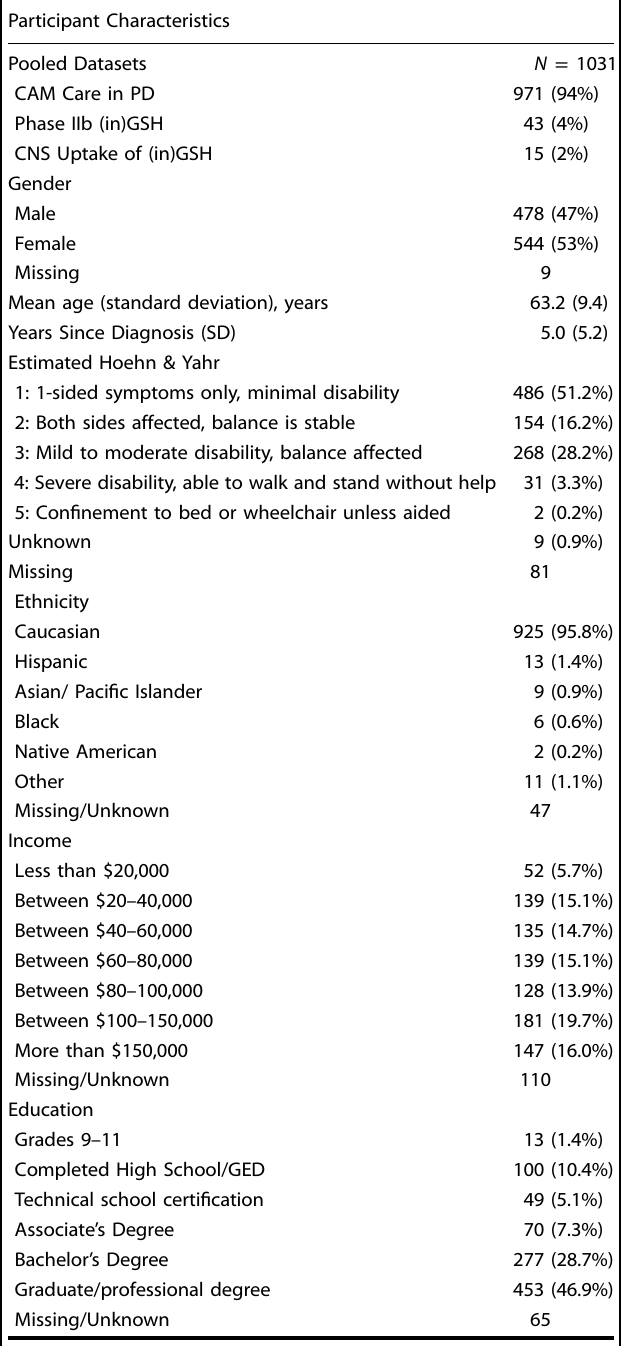
Table 1. Demographic and selected other characteristics of